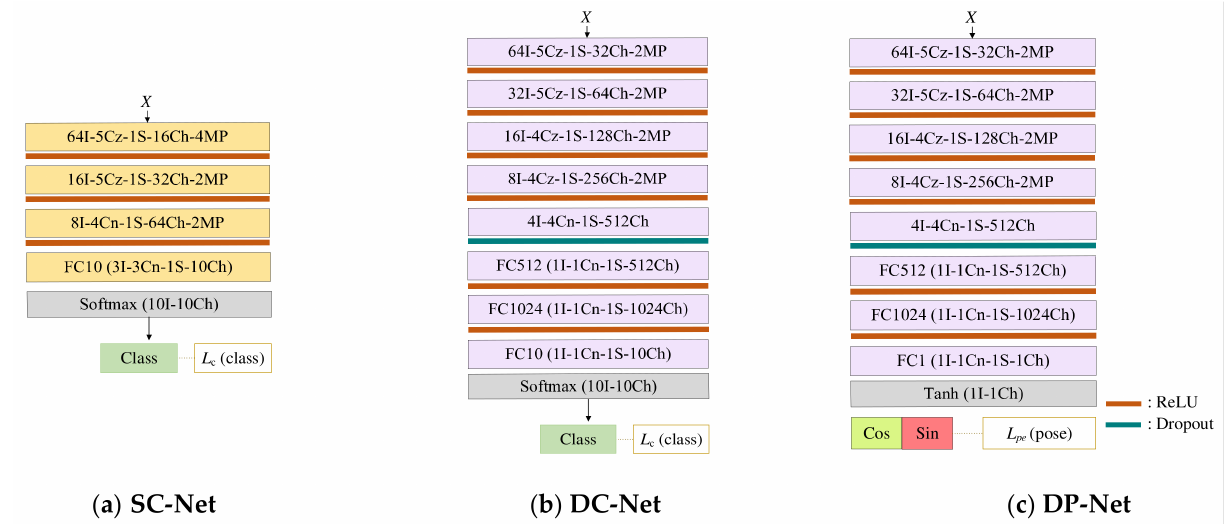
Figure 3. The three types of network structures used for proposed indirect evaluation methods for SAR target image generation: ( a ) simple classifier (SC-Net), ( b ) deep classifier (DC-Net), and ( c ) deep pose-estimator